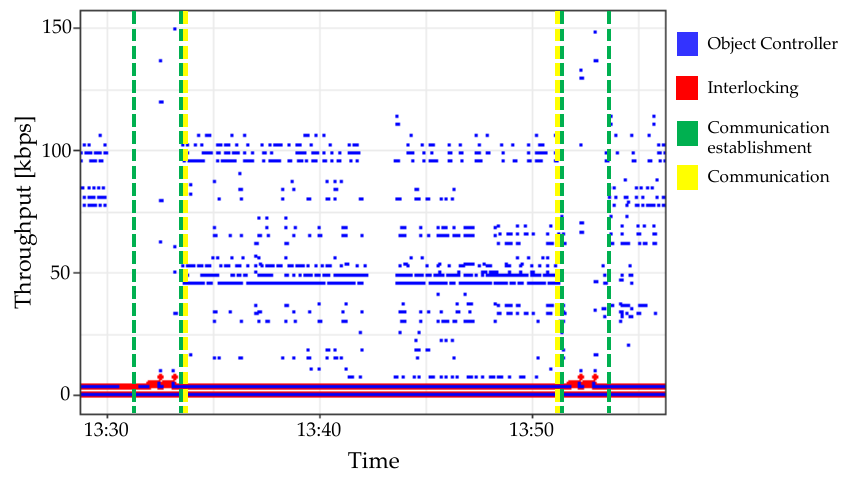
Figure 4. Signalling bit rate for a set of